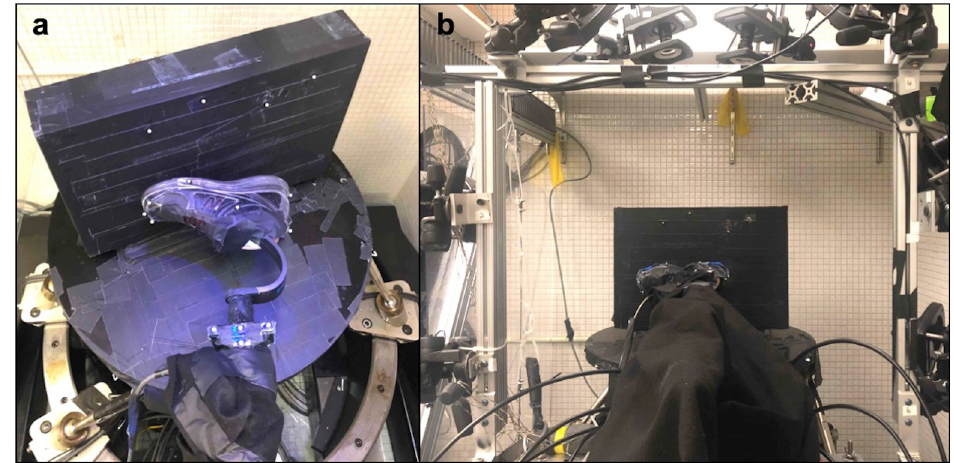
Fig 1. Mechanical testing apparatus with example commercial prosthetic foot setup. (a) Aerial view of prosthetic foot setup for testing with in-line load cell and reflective markers (b) view of R2000 Rotopod parallel robot with a vertically-mounted plate as a loading